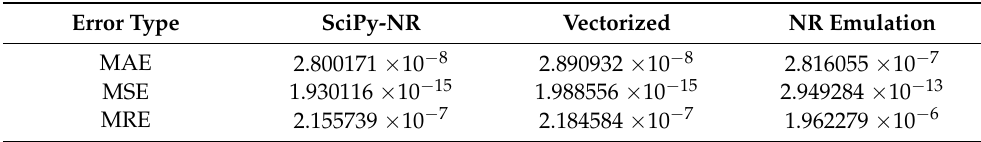
Table 3. Implied volatility estimation